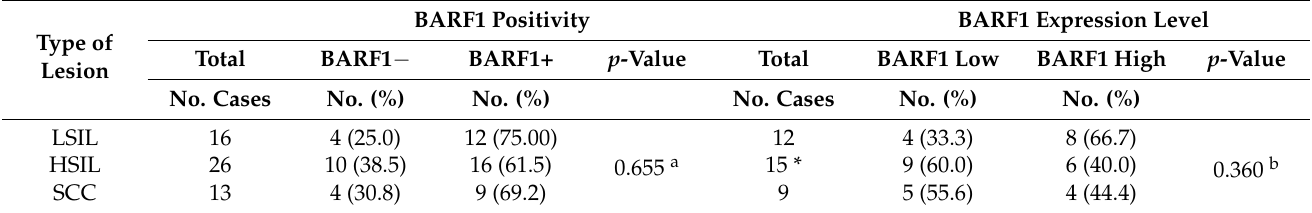
Table 5. Expression of BARF1 according to type of